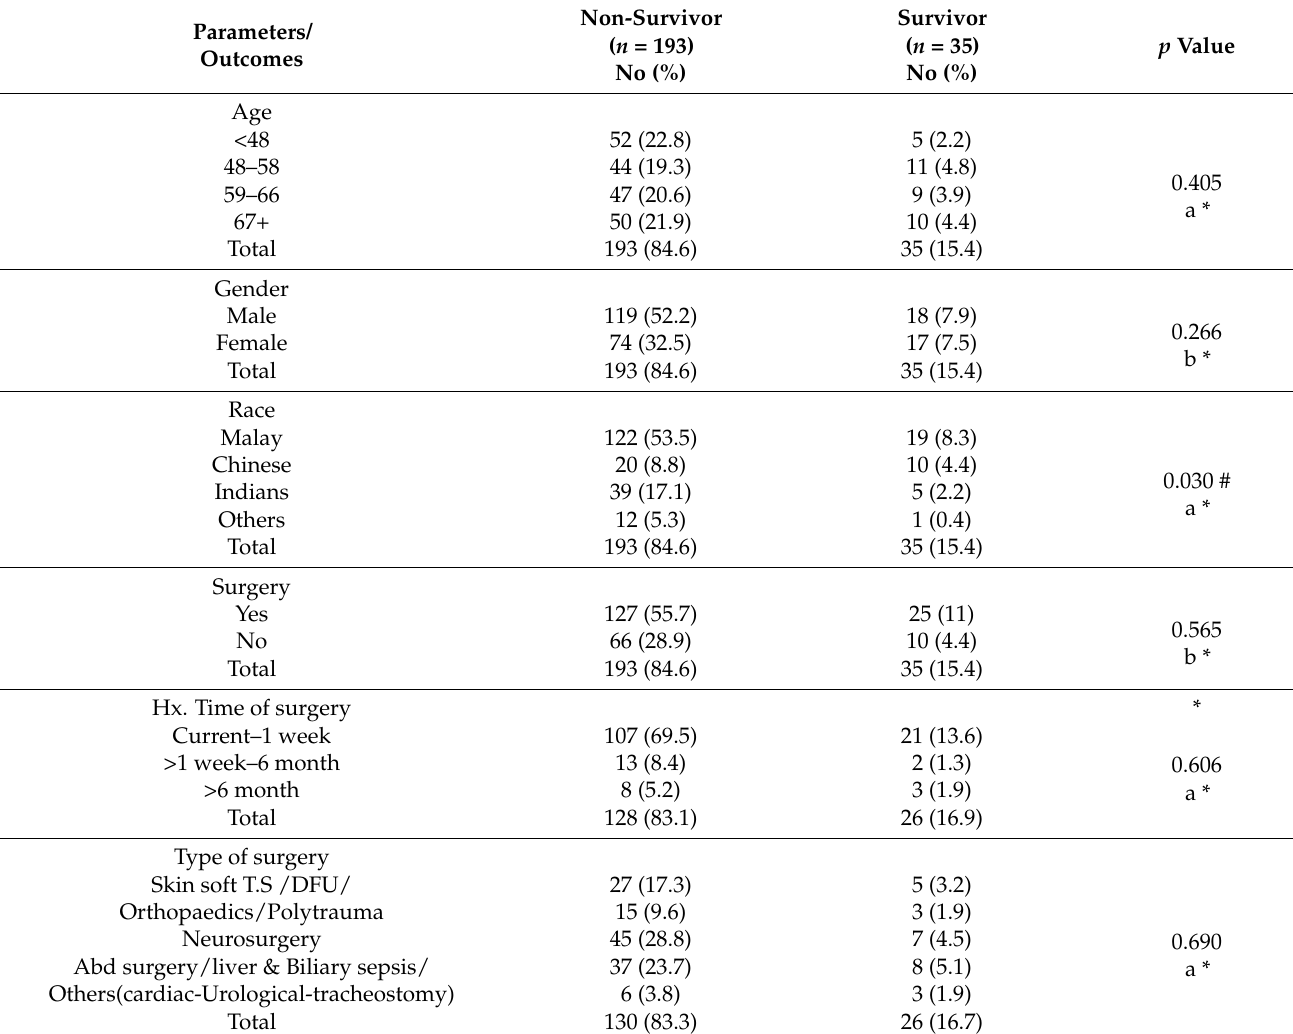
Table 1. The Association of Demographic and Baseline Clinical Characteristics of Entire Sample with